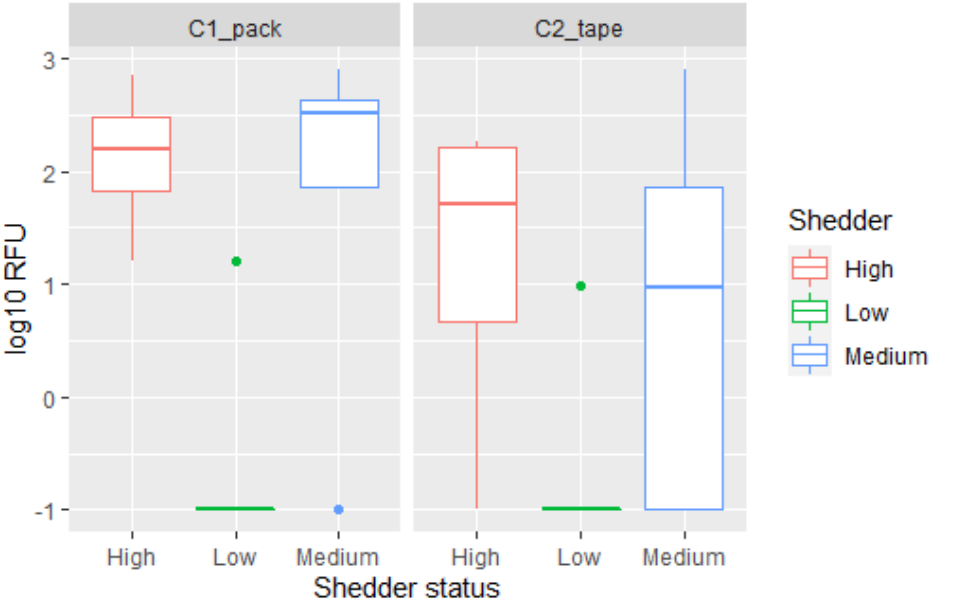
Figure 6. Boxplot displaying the log10 RFU for the drugs wrapper (C1 pack ) and the previous handler (C2 tape ) of the tape according to the shedder classification of the participants.